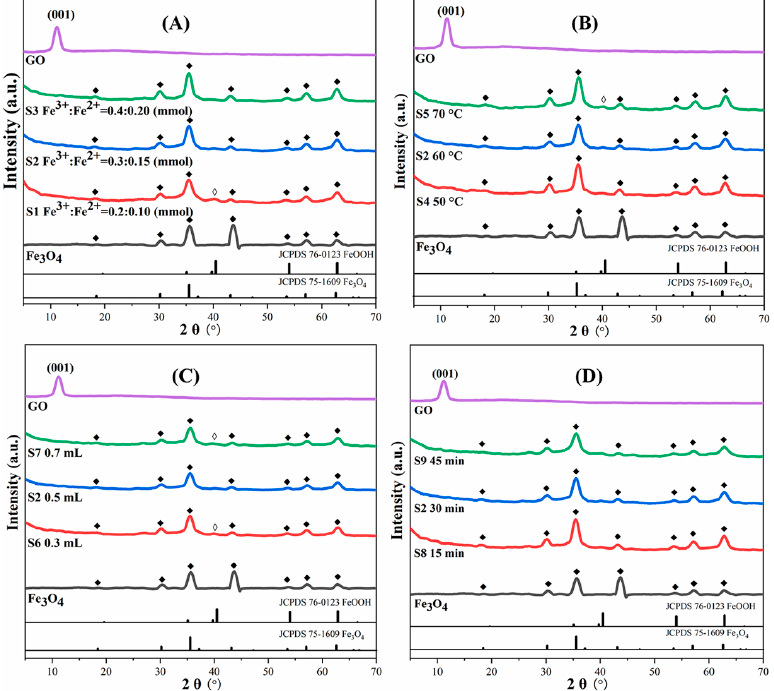
Figure 3. XRD patterns of GO and GO@Fe 3 O 4 prepared under various conditions ( ◆ : Fe 3 O 4 ◇ : FeOOH). ( A ) various ferric salt dosages; ( B ) various temperatures; ( C ) various ammonia water dos- ages; ( D ) various reaction